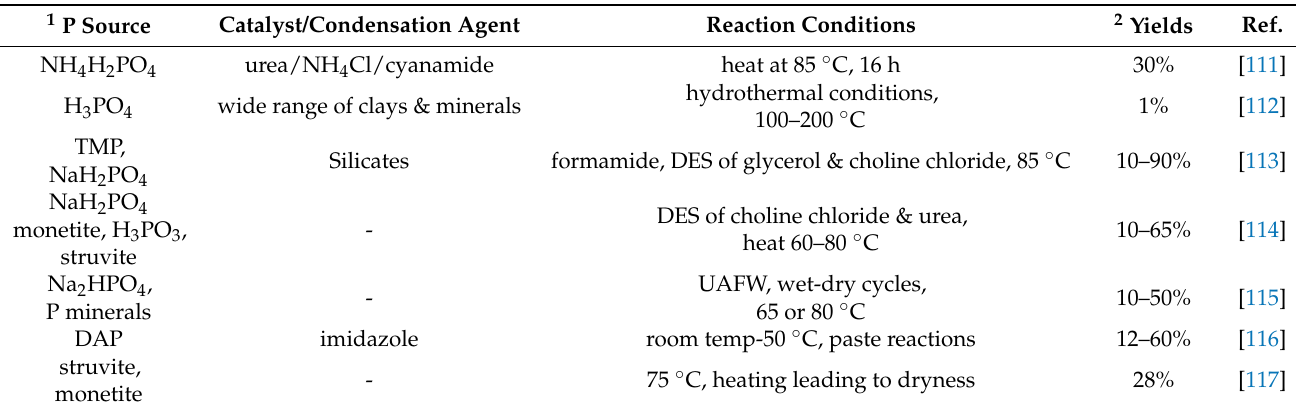
Table 1. Prebiotic synthesis of glycerol